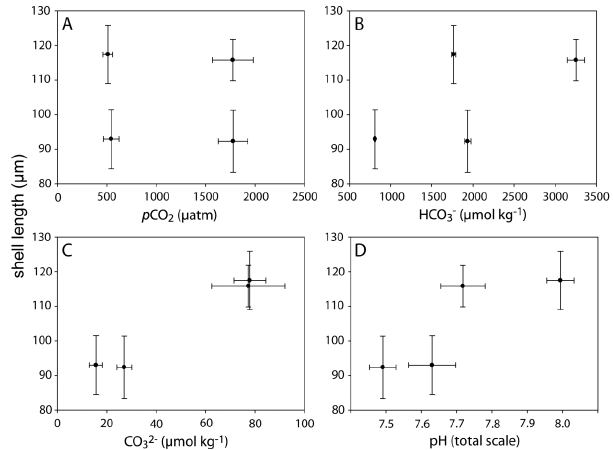
Figure 3. Exp. 3 Calcification response (measured as shell length) of M. edulis larvae kept under modified carbonate chemistry and C T limiting conditions for four days during the lecithotrophic phase. Shell length is plotted against seawater (a) p CO 2 , (b) [HCO − ], (c) [CO 2 − ] and 3 3 (c) [CO 2 − ] and (d) pH. Data represent mean ± 3